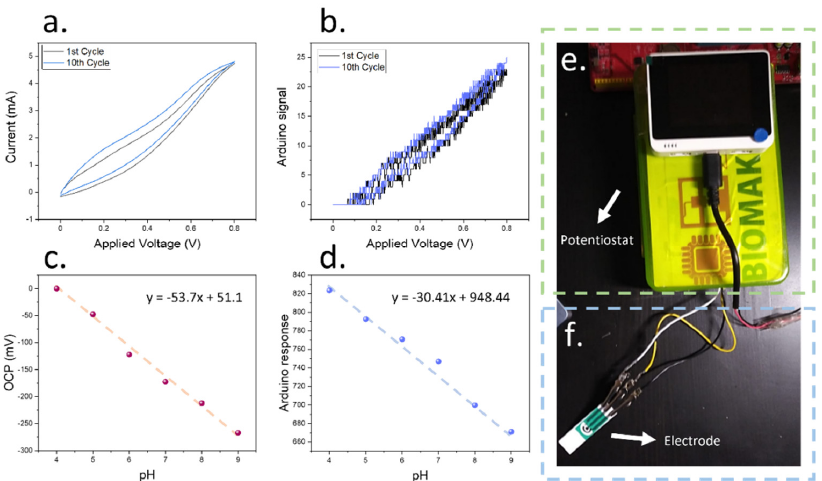
Figure 3. ( a ) Cyclic voltammogram obtained during the electrodeposition of ruthenium oxide films onto copper electrodes using laboratory equipment. The differences between the first and tenth cycles are shown. ( b ) Comparison with cyclic voltammogram obtained using the low-cost